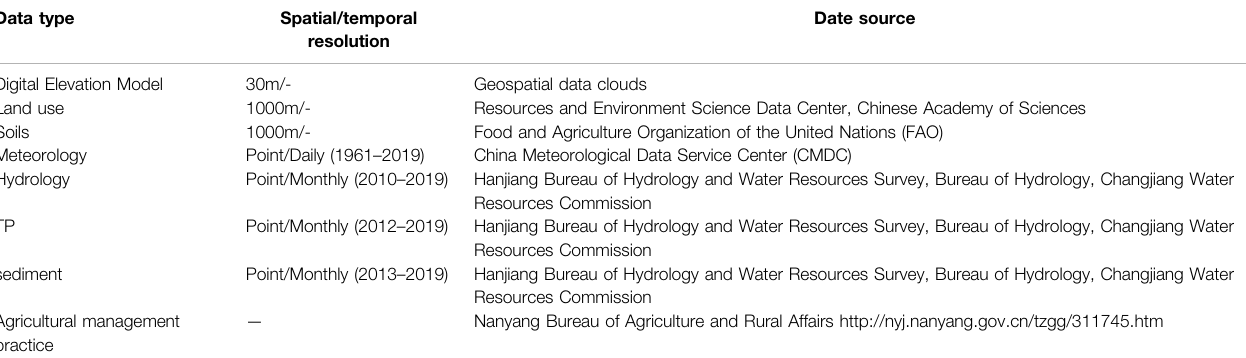
TABLE 2 | Data sets used in the model setup.